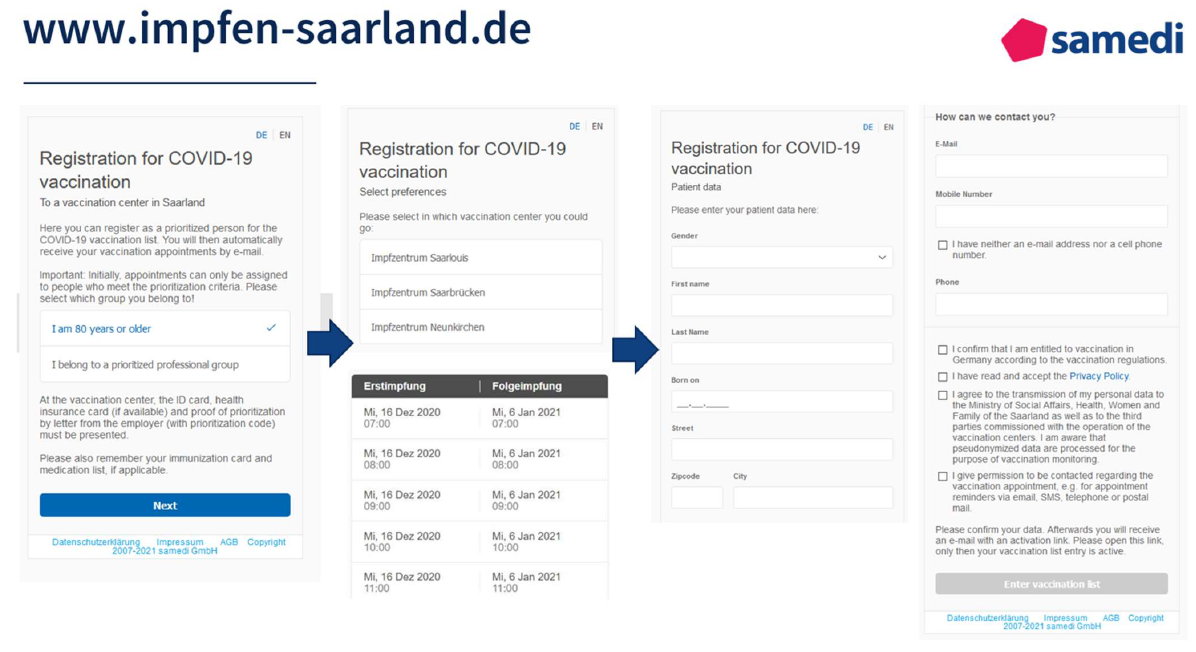
Figure A2. Illustration of the vaccination portal of Saarland ant its userflow.